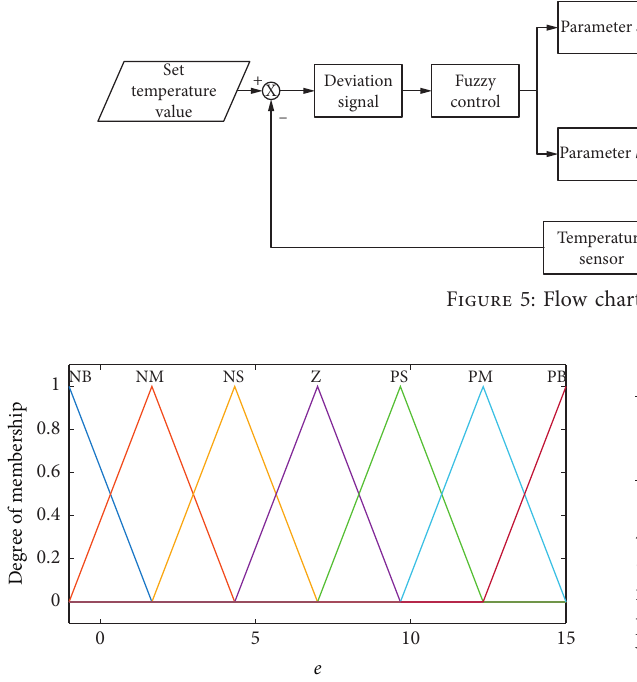
Figure 6: Membership function of temperature error e .